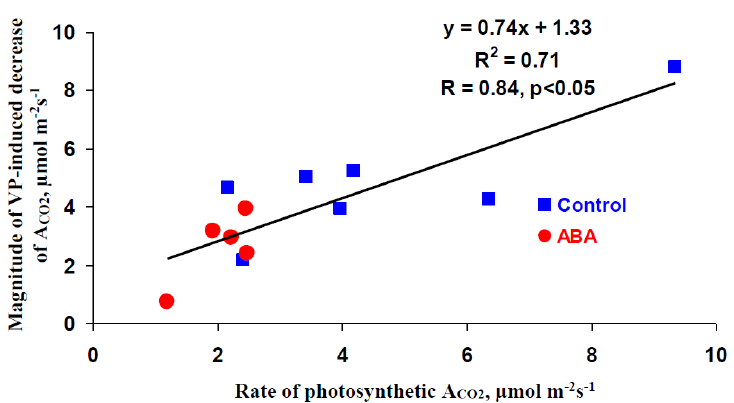
Figure 6. A scatter plot showing the rates of photosynthetic CO 2 assimilation (A CO2 ) and magnitudes of local burning-induced decreases in A CO2 in pea seedlings ( n = 12). R 2 and R are determination and correlation coefficients,